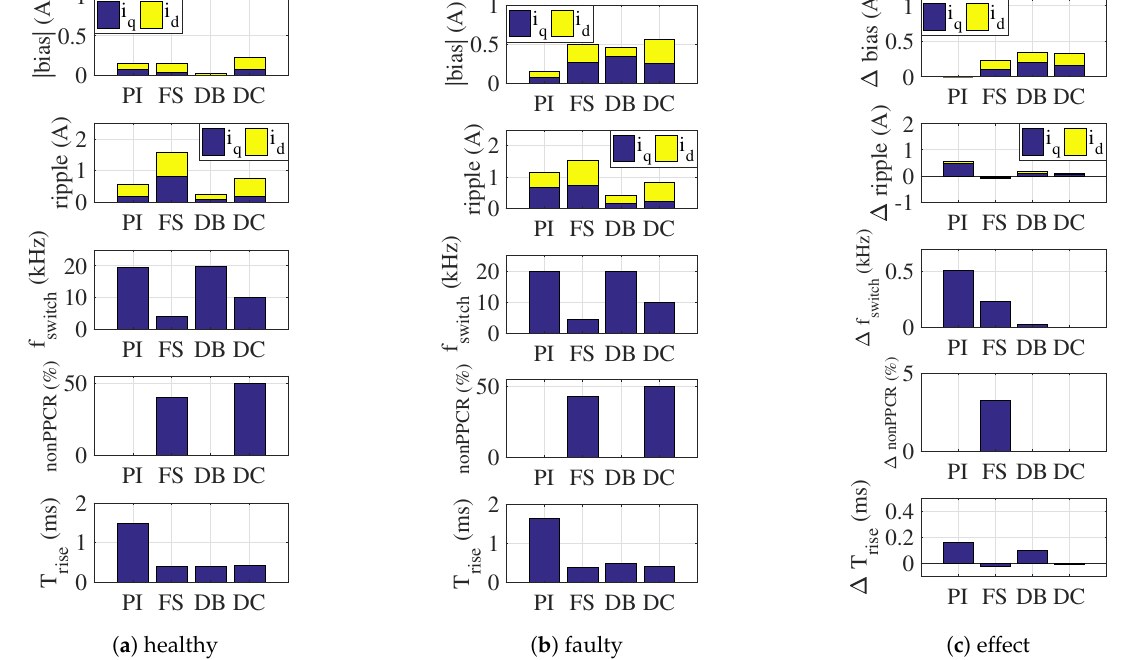
Figure 10. Experimental KPIs for V dc = 200 V and N = 800